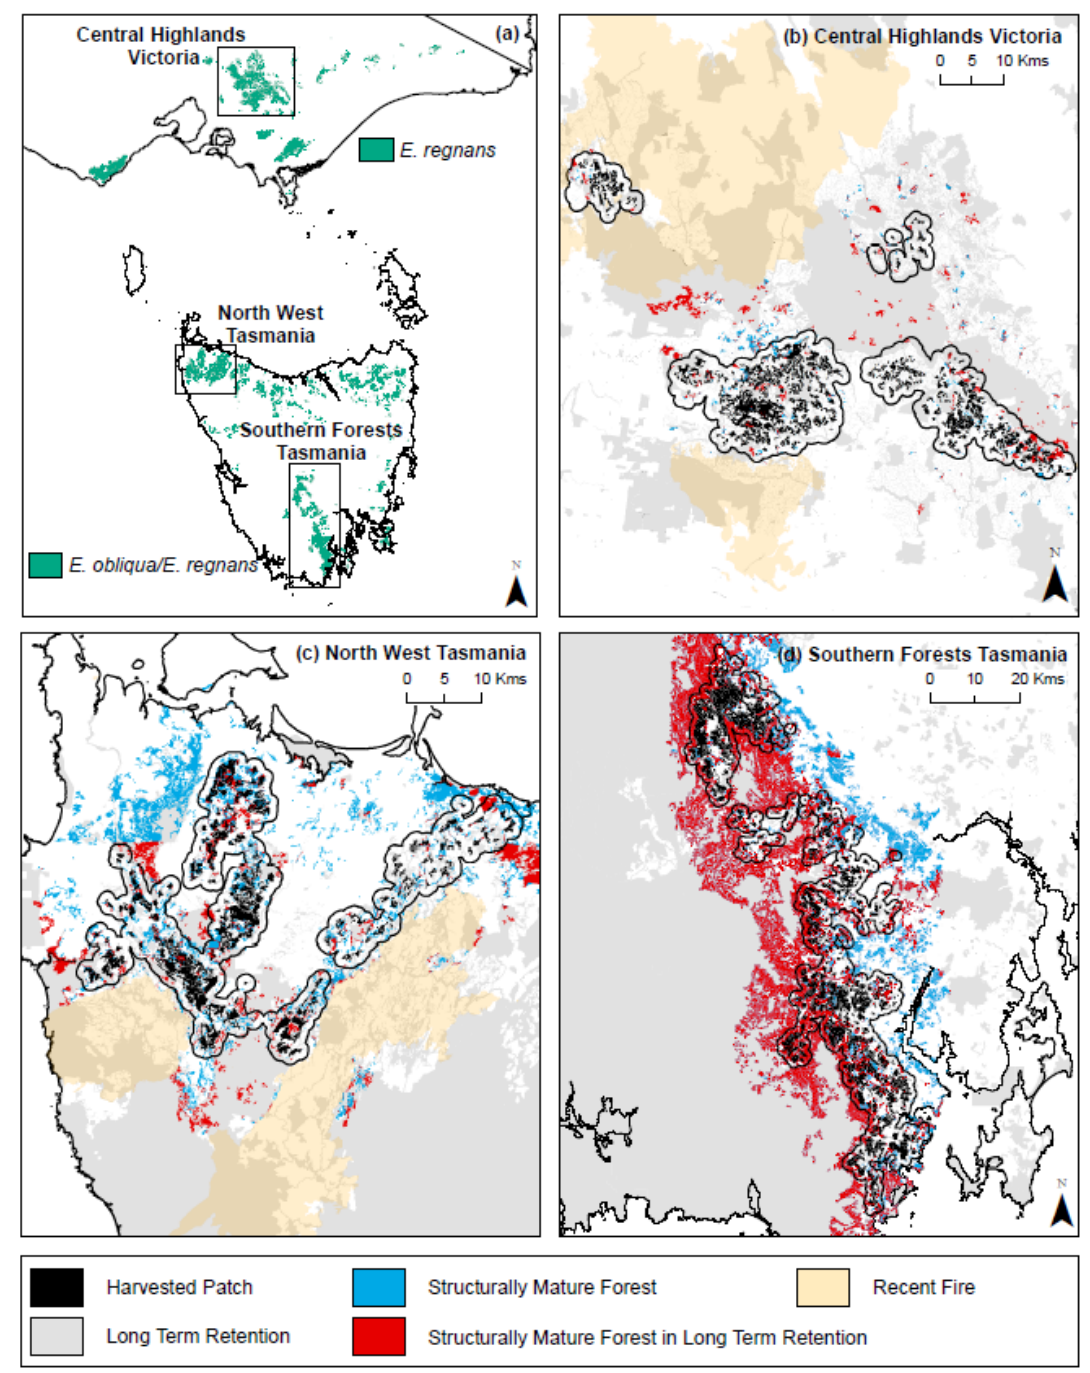
Figure 2. ( a ) Location of three study landscapes in wet eucalypt forests managed for timber production in south-eastern Australia. Central Highlands Victoria is dominated by Eucalyptus regnans F.Muell. Southern Forests Tasmania and North West Tasmania are dominated by Eucalyptus regnans F.Muell and/or Eucalyptus obliqua L'H é r.; ( b – d ) Harvested patches (1960–2015) and structurally mature forest ( ≥ 5% cover of irregular crowns) within the three study areas. Only mature forest patches within 10 km of harvested areas are shown. Areas in long-term retention and areas burned in the 2009 (Victoria) and 2016 (Tasmania) fires are shown. The solid line illustrates a 1000 m buffer within which mature forest influence and landscape context metrics were calculated.